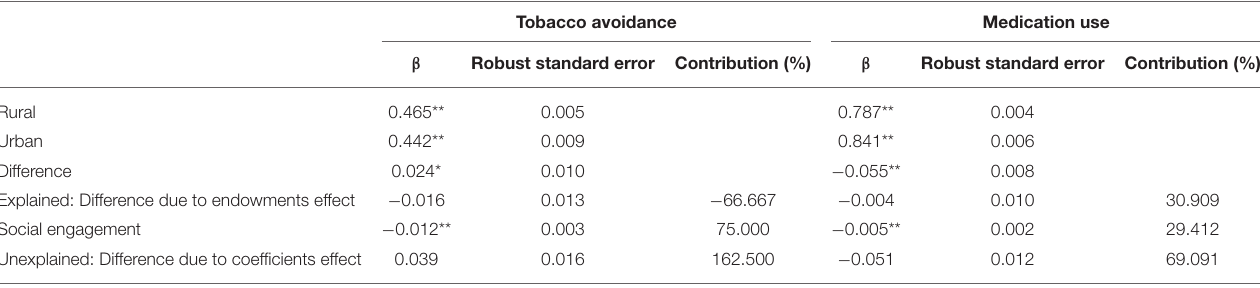
TABLE 5 | Fairlie decomposition results of the effect of social engagement on the urban-rural disparity in tobacco avoidance and medication use behaviors among older adults.